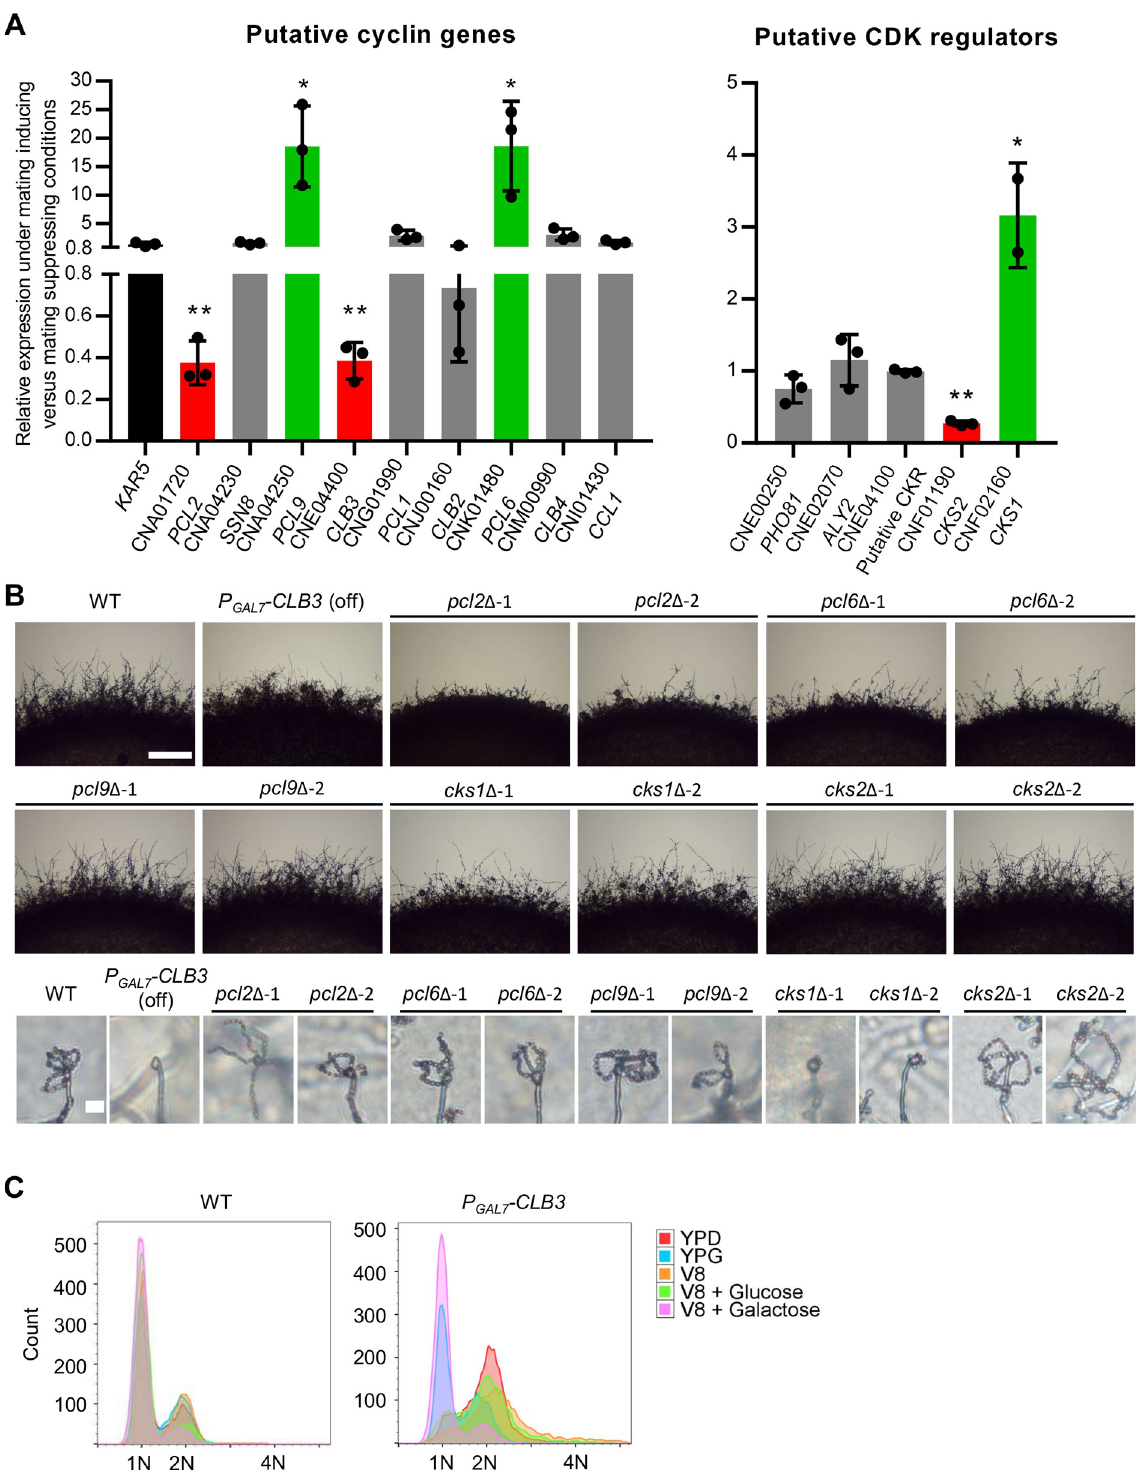
Fig 1. Identification of cell cycle regulating genes involved in unisexual reproduction. (A) Differential expression patterns of cell cycle regulating genes in wild type XL280 α cells upon incubation for 36 hours on mating-inducing V8 agar medium versus nutrient rich YPD agar medium were examined by qRT-PCR. The error bars represent the standard deviation of the mean for three biological replicates. Red and green colors indicate genes that are significantly down- and up- regulated during unisexual reproduction compared to the control gene KAR5 ,